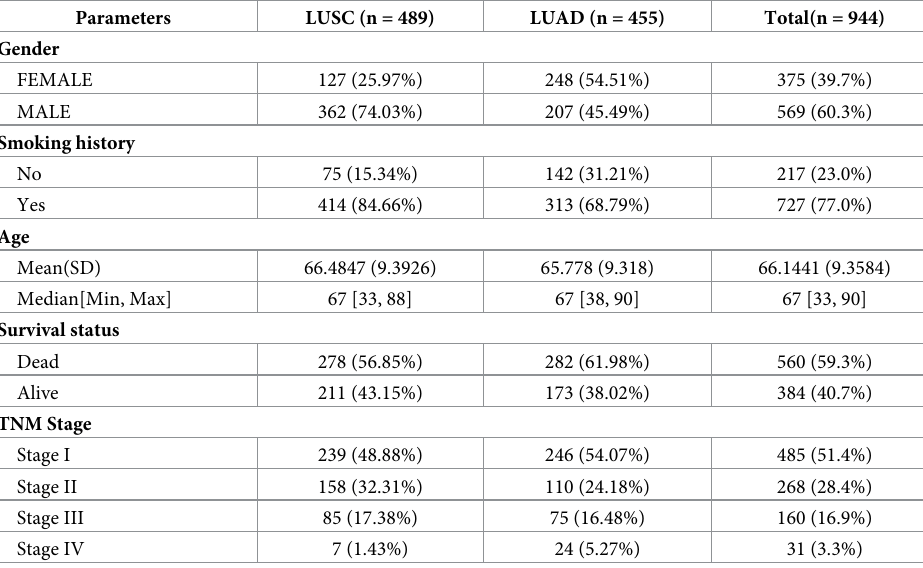
Table 1. The clinicopathological characteristics of 944 NSCLC